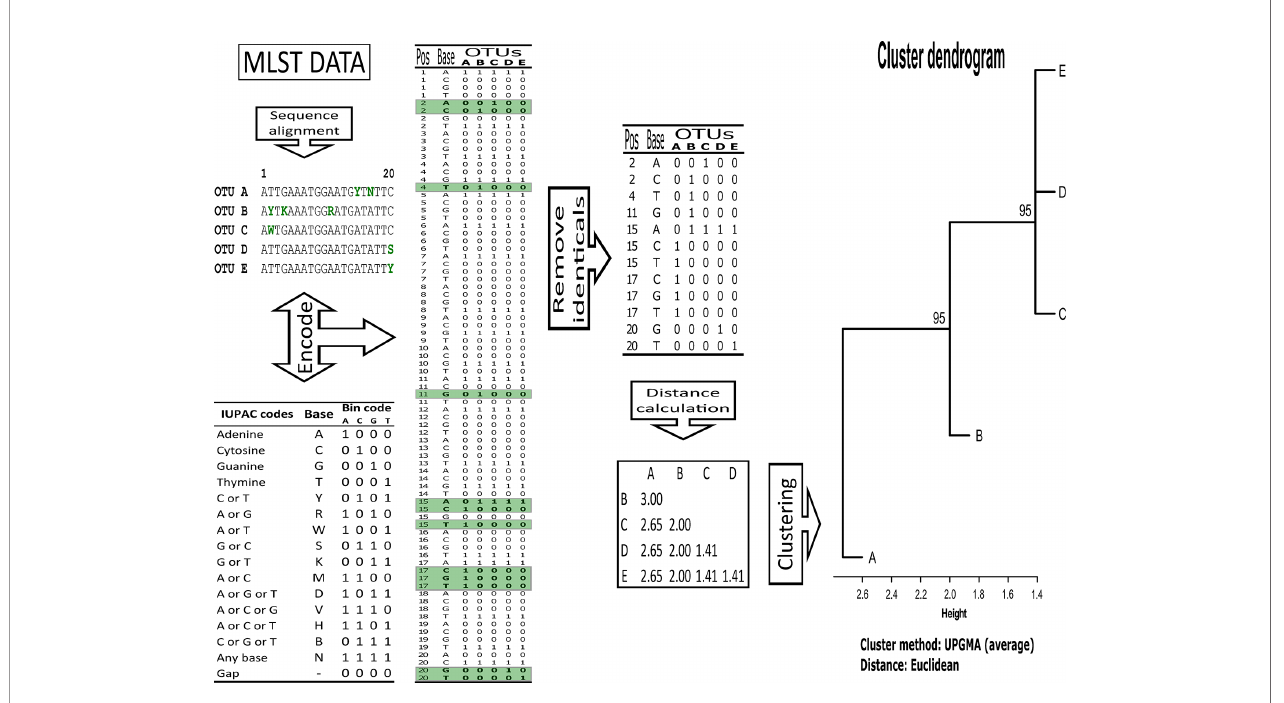
FIGURE 1 | Overview of the methodological pipeline for MLST data cluster